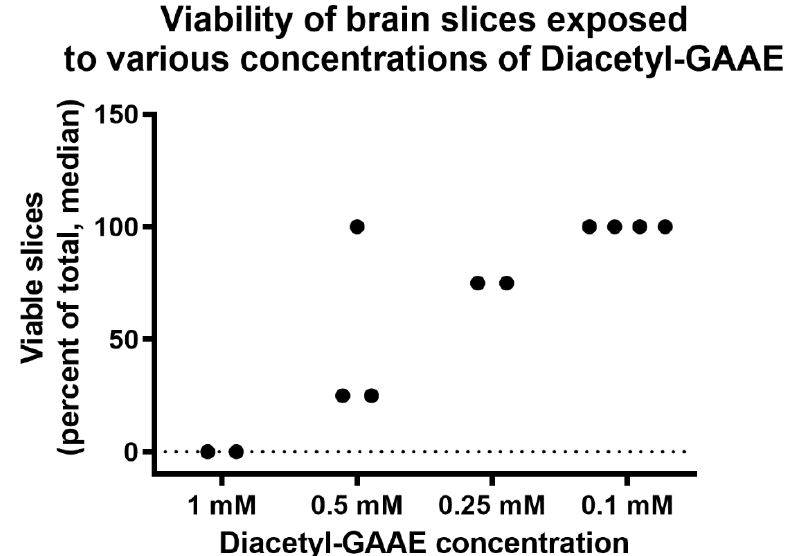
Figure 9. Percent of slices in each batch that showed synaptic transmission after incubation with various concentrations of Diacetyl-GAAE. p = 0.0089, analysis of variance.